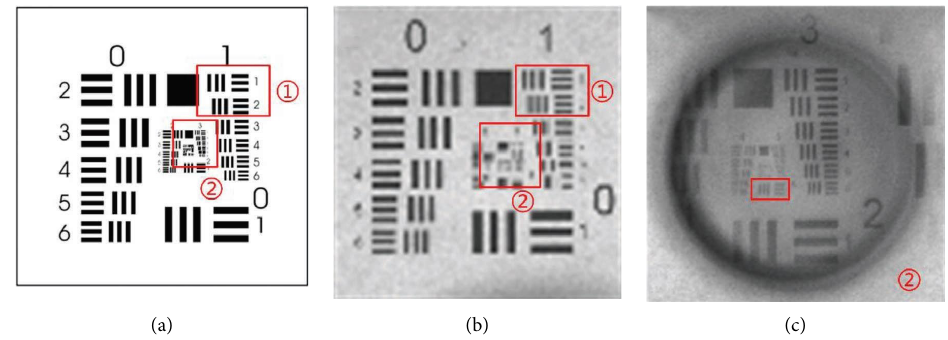
Figure 7: USAF test chart imaging results. (a) USAF test chart in 1951. (b) Imaging result of the peripheral channel. (c) Te imaging result of 9 × foveated zoom